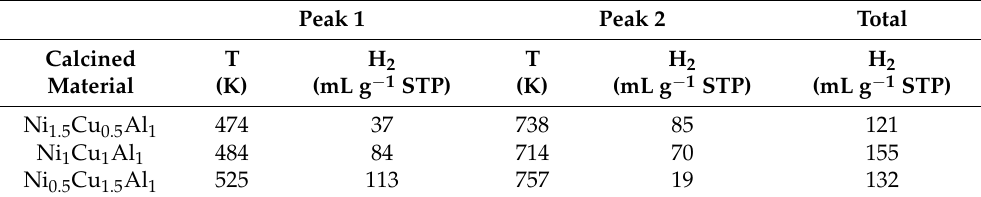
Figure 5. H 2 -TPR of LDH precursors calcined at 673 K for 4 h. Table 4. Specific hydrogen consumptions during TPR of calcined LDH